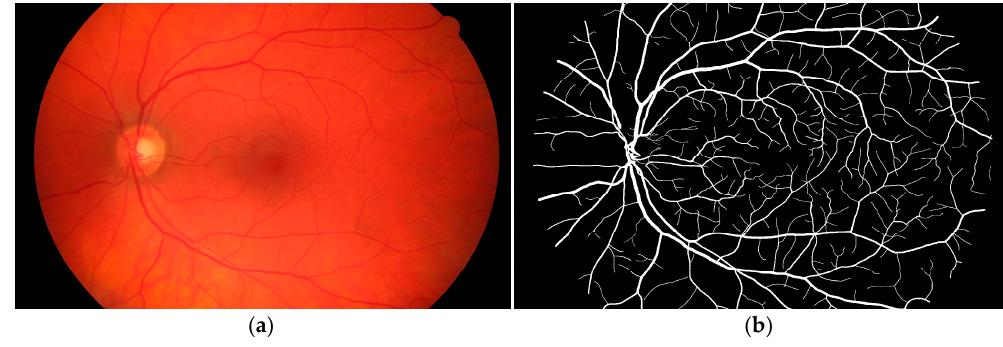
Figure 3. Example of a fundus image from the proposed database: ( a ) Example of a raw image im0002.jpg; ( b ) The manual segmentation of the vessels.